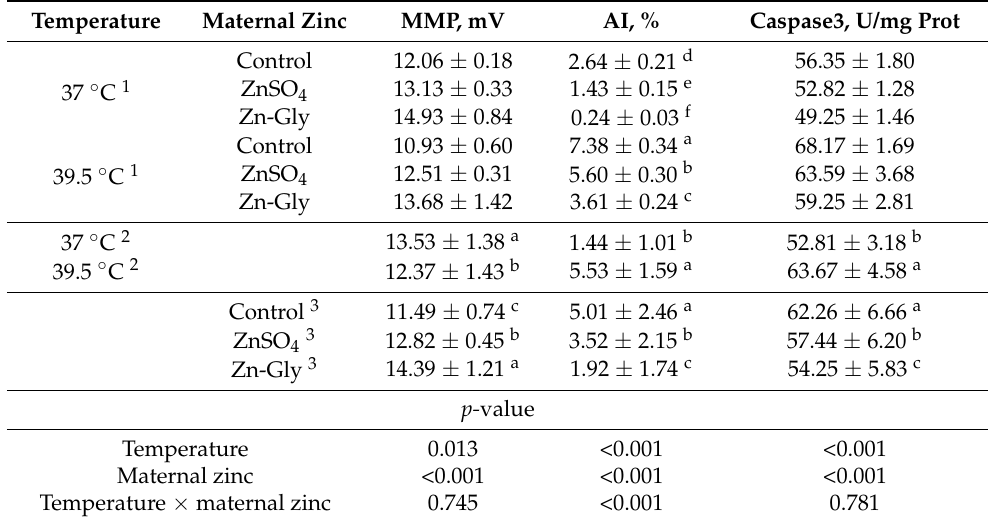
Table 6. Effects of maternal zinc on hepatocellular mitochondrial membrane potential, apoptosis Index and caspase3 activity in embryos under heat stress (mean ± S.E.).